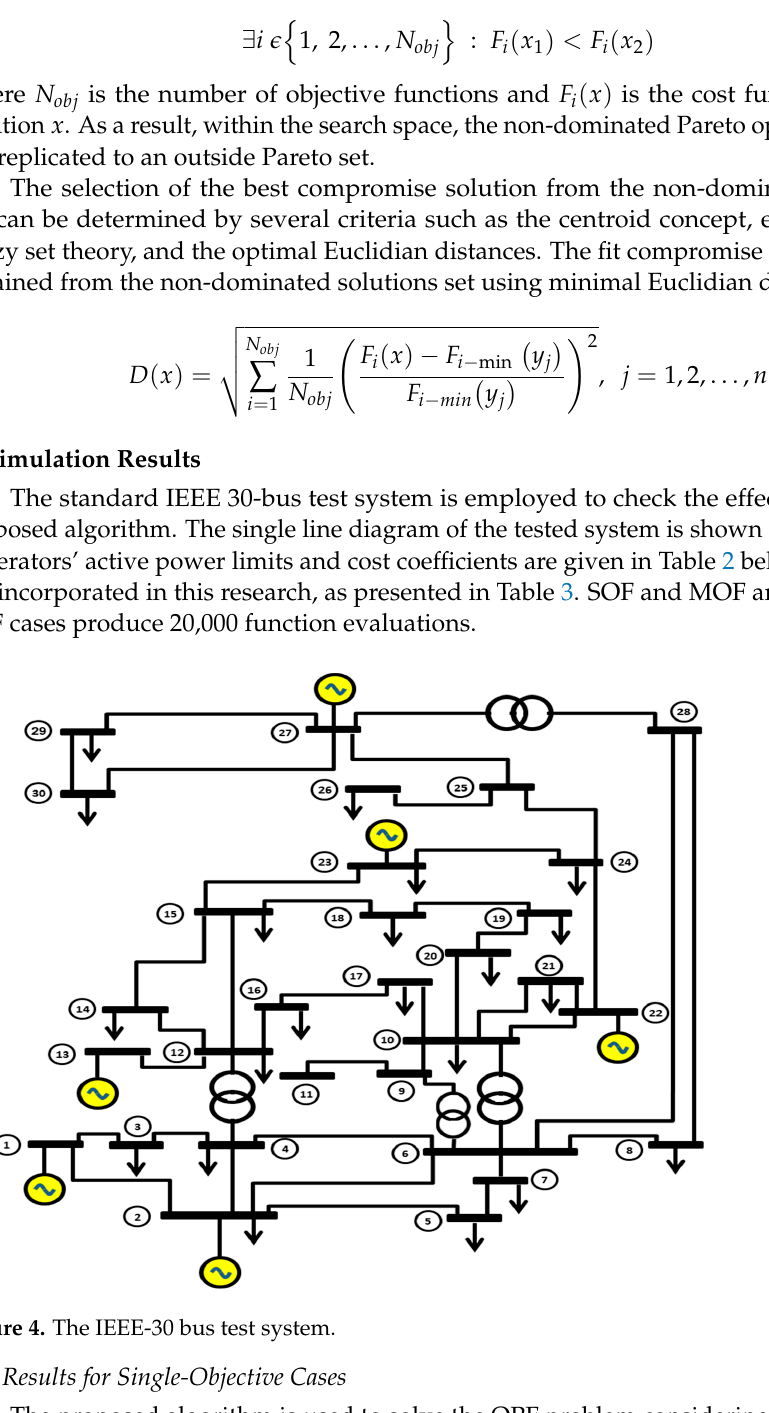
Table 3. Summary of various OPF formulations